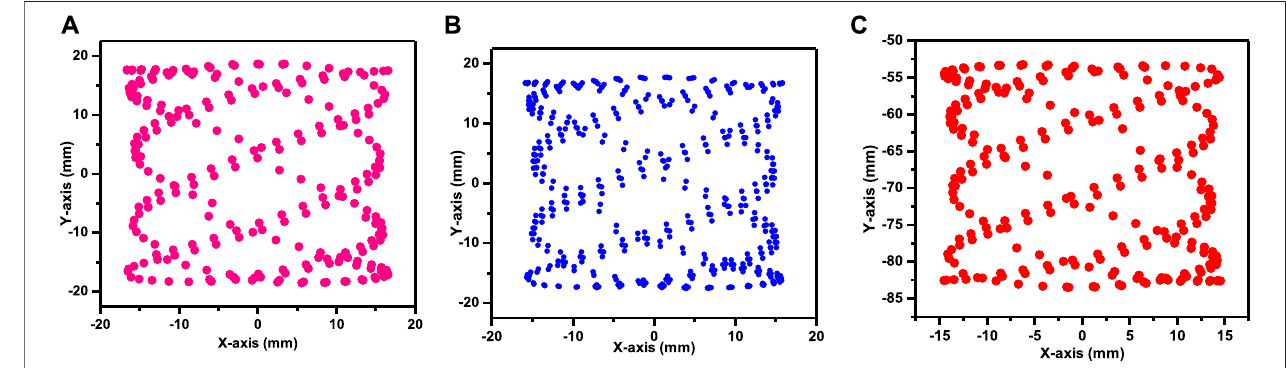
FIGURE 6 | Spot patterns simulated by optical software, (A – C) Spot patterns on spherical mirrors M 1 , M 2, and M 3 of three different MPCs, respectively. The initial ray parameters for the spot pattern are listed in Table 1 . Pass counts n = 248 times.